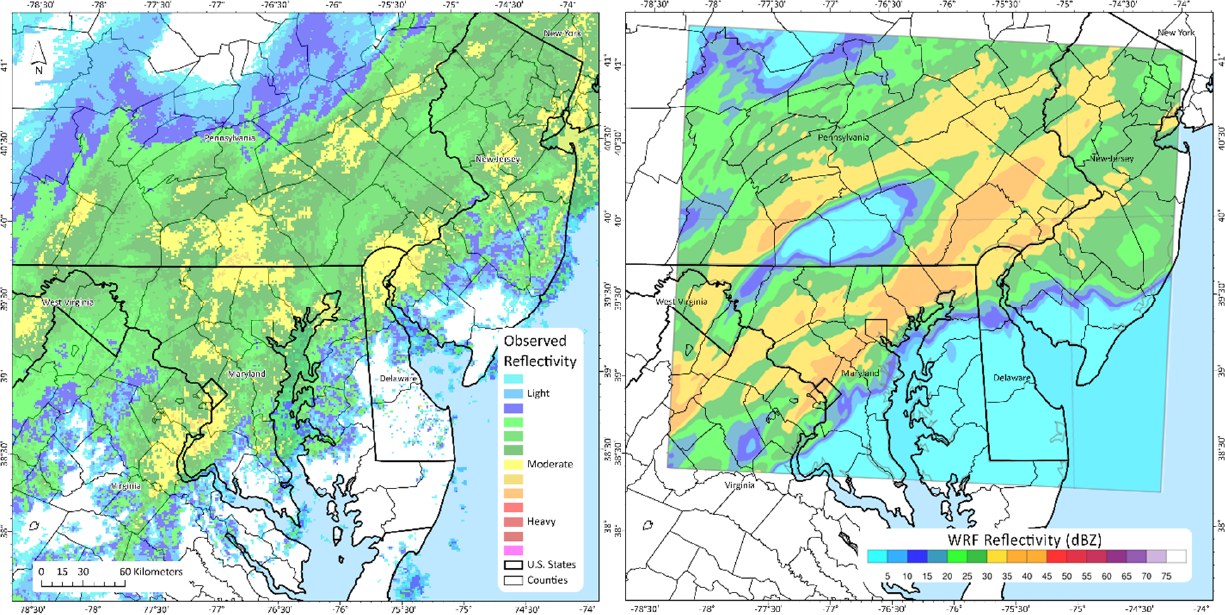
Figure 4. WRF simulations of surface temperature ( ℃ ) in control ( top left ), NOURBAN ( top right ), and DCBAL ( bottom ) land cover modification schemes. Valid at 0000 UTC on 6 February 2004.